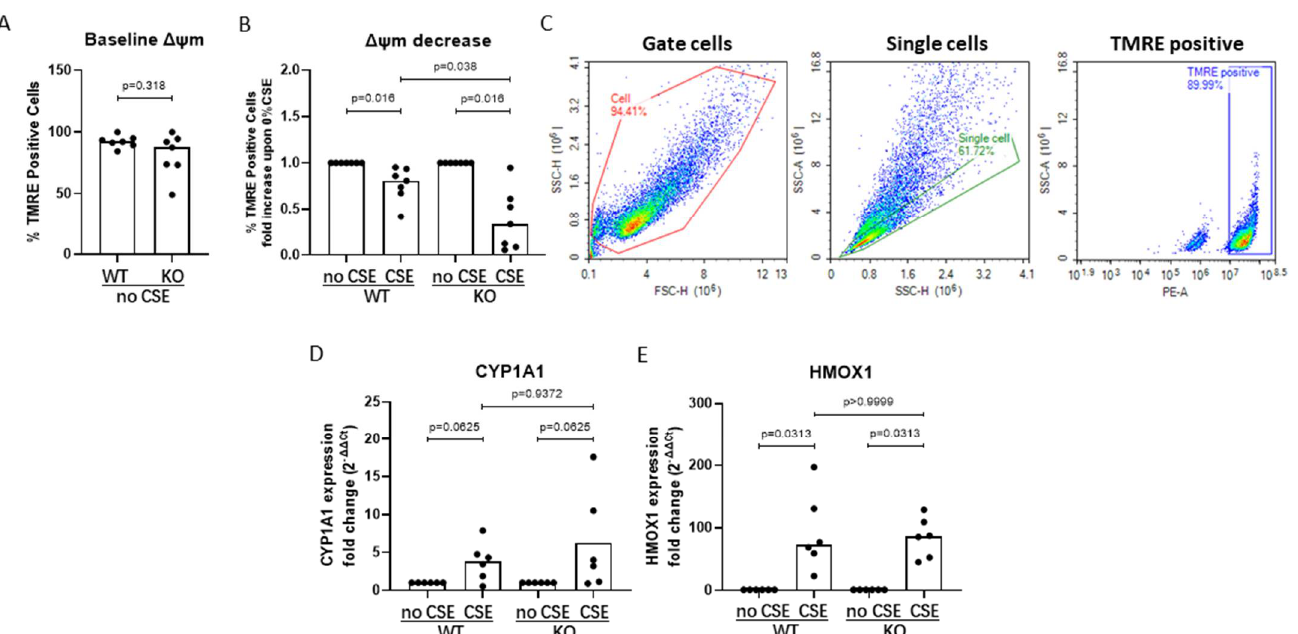
Figure 4. AHRR knockout attenuates the proliferation of 16HBE cells without altering AHR-related genes. 16HBE wild-type (WT) or AHRR knockout (KO) cells ( n = 6) were seeded in triplicate in 96-wells plates, and the cell proliferation was measured using MTS assay at day 2, day 4 and day 6 after seeding. Cell proliferation rate of WT and AHRR KO cells is shown and depicted as median with interquartile range ( A ). 16HBE WT and AHRR KO cells ( n = 6) were seeded in duplicate in 24-well plates, grown to confluence, serum-deprived overnight, incubated in medium with/without 10% CSE for 6 h and harvested for isolation of RNA. The mRNA levels of P27 ( B ), P21 ( C ), BAX ( D ) and CYP1A1 ( E ) were determined using qPCR, related to the expression of housekeeping genes B2M and PPIA and expressed as 2 −ΔCt . Median levels are indicated. The differences between WT and AHRR KO were tested using the Mann–Whitney test. p -values are as indicated between the groups.